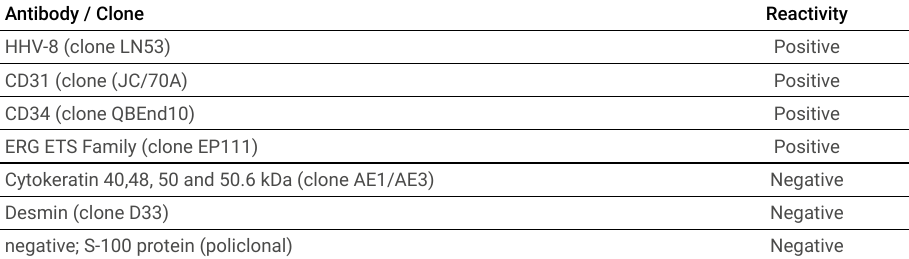
Table 1. Oral cavity Kaposis’s sarcoma immunohistochemistry profile.